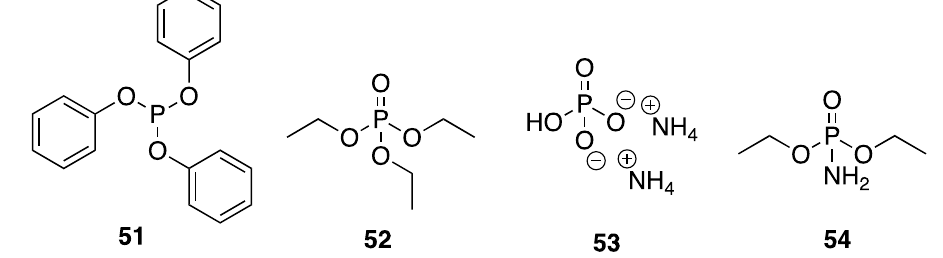
Figure 22. Molecular structures of P-species used.